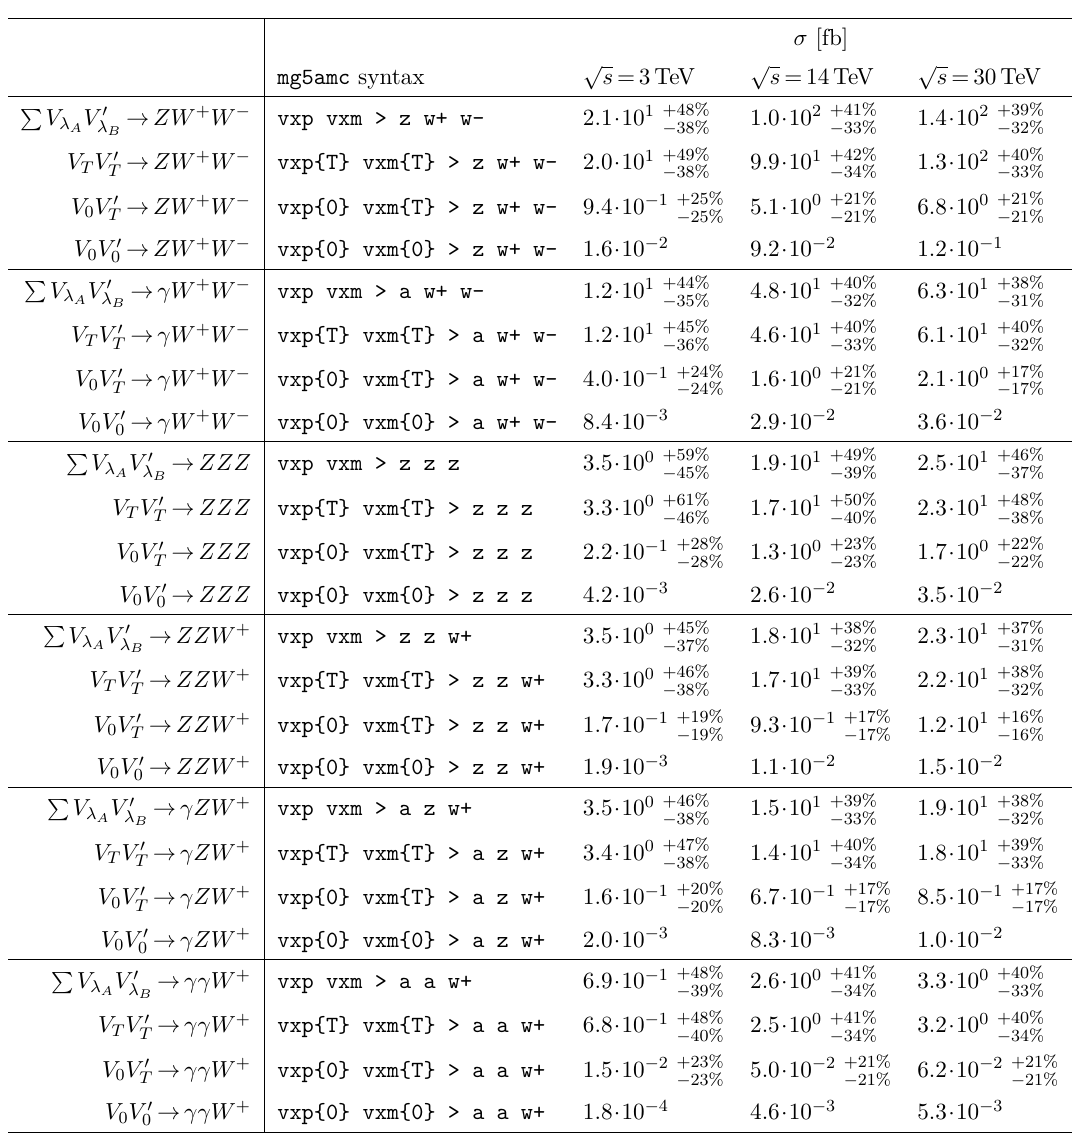
Table 7 . Same as table 4 but for V V V